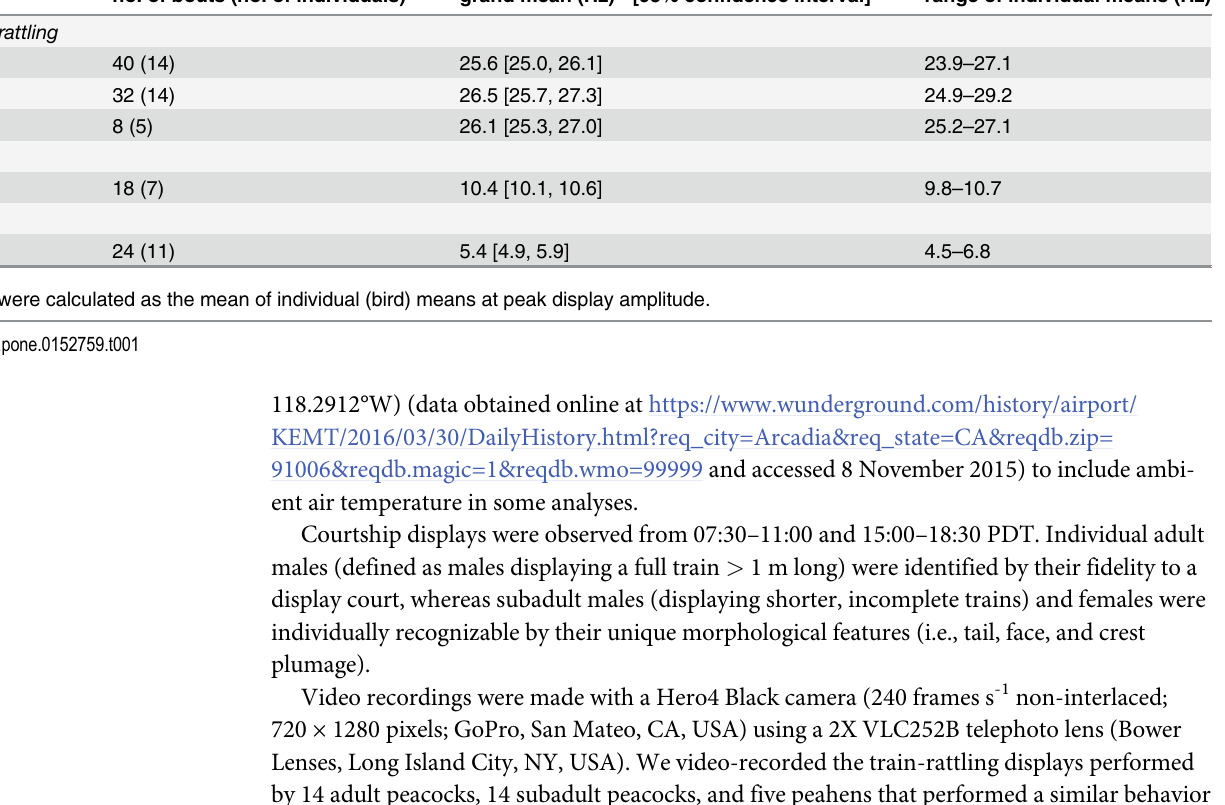
Table 1. Feather vibration frequencies (Hz) during peafowl shaking behaviors. no. of bouts (no. of